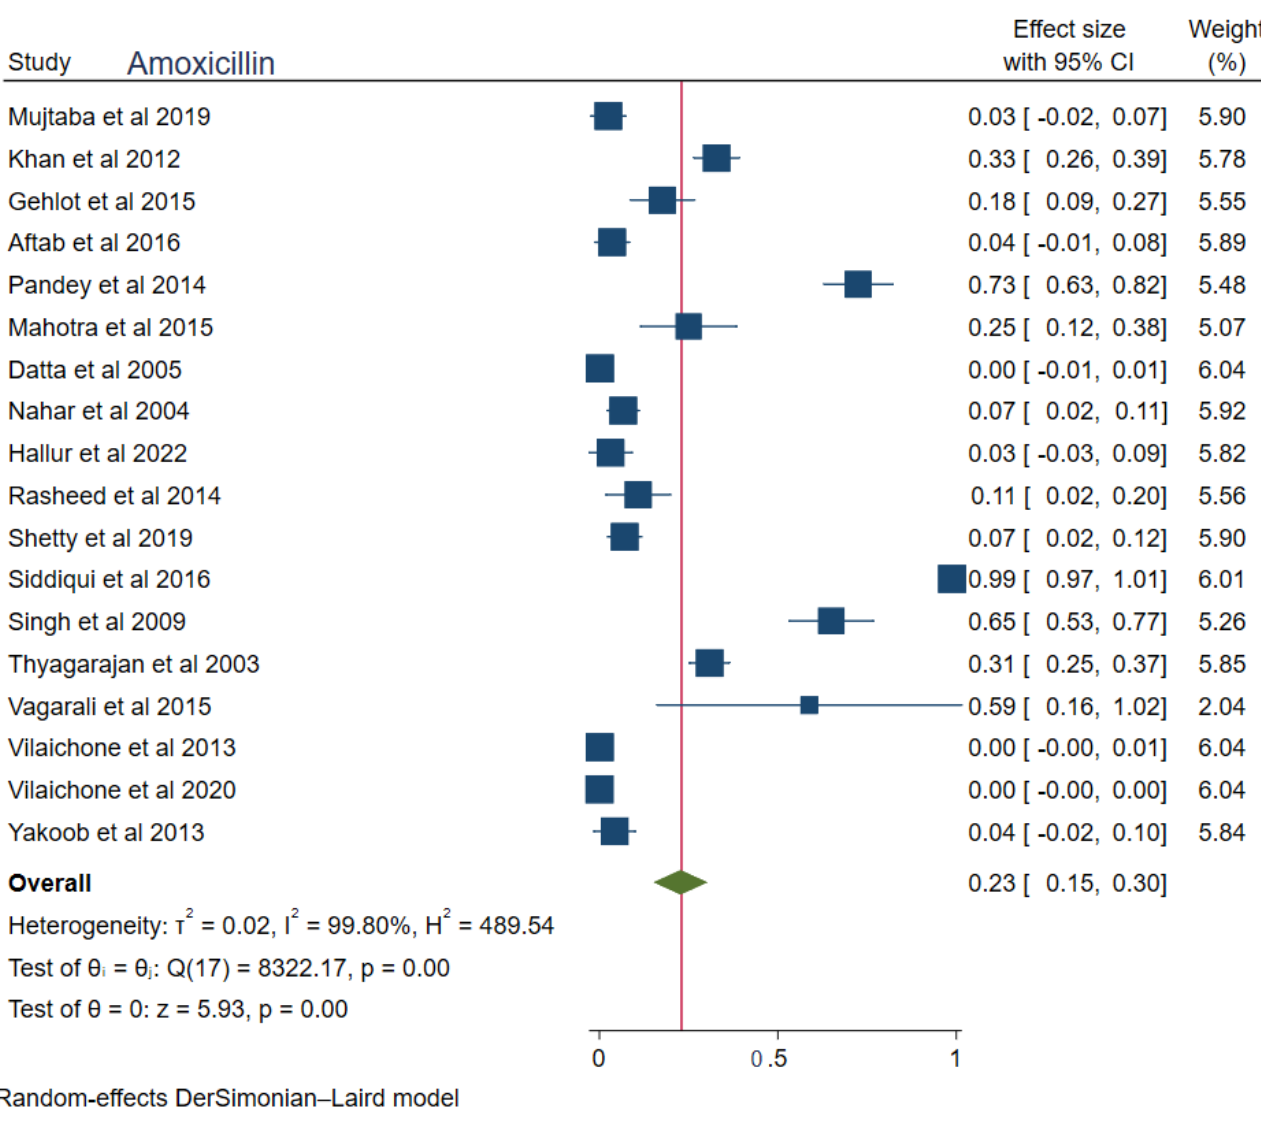
Figure 4. Forest Plot Showing Amoxicillin Resistance. (Reference studies: [15,21–25,27,29–31,33– 38, 40])